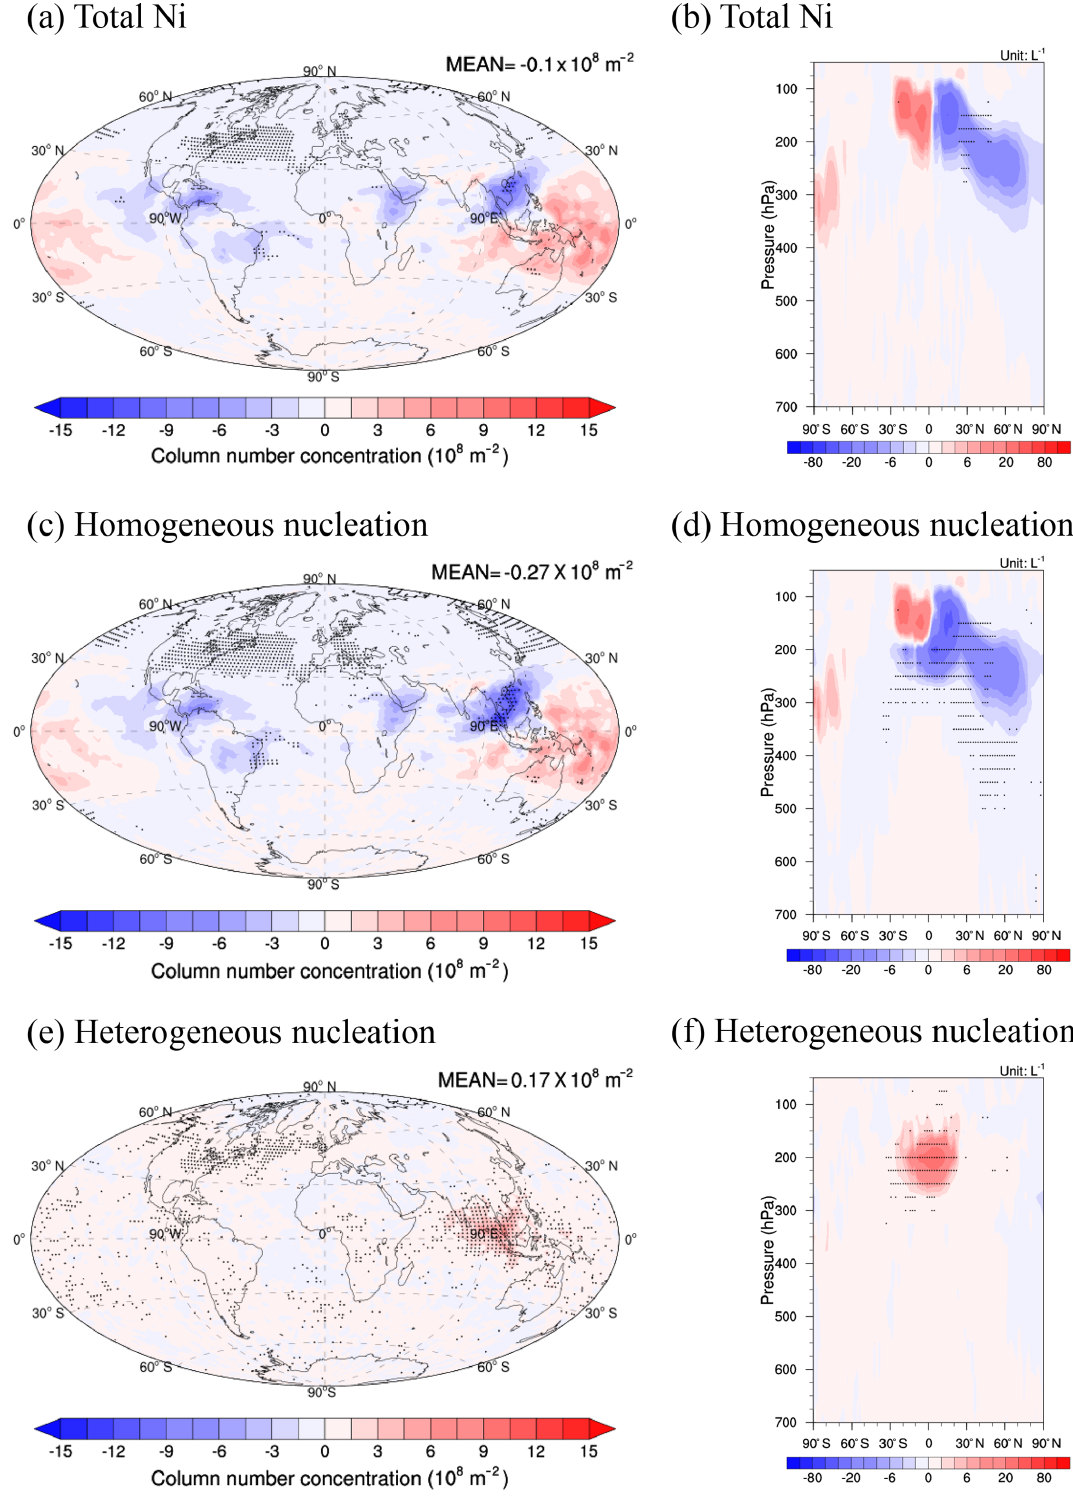
Figure 3. The annual average change in column number concentration (a, c, e) and zonal average number concentration (b, d, f) of total ice (a, b) , ice from homogeneous nucleation (c, d) , and ice from heterogeneous nucleation (e, f) for the difference between the PD_Base and PI_cSoot cases. Differences significant at the 90% level according to a Student’s t test are depicted by